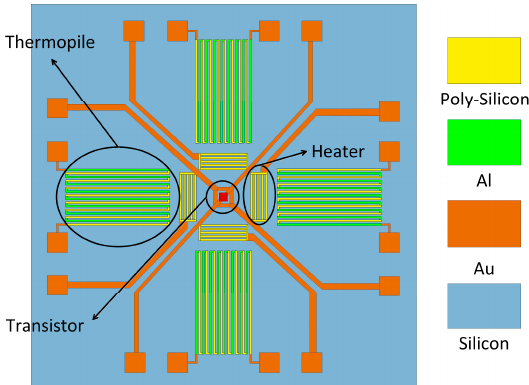
Figure 1. The layout of the thermal wind sensor. Four heaters heat the whole chip. A central transistor measures the average temperature of the sensor chip, while four thermopiles measure the temperature difference between the upstream and downstream sensor surfaces.